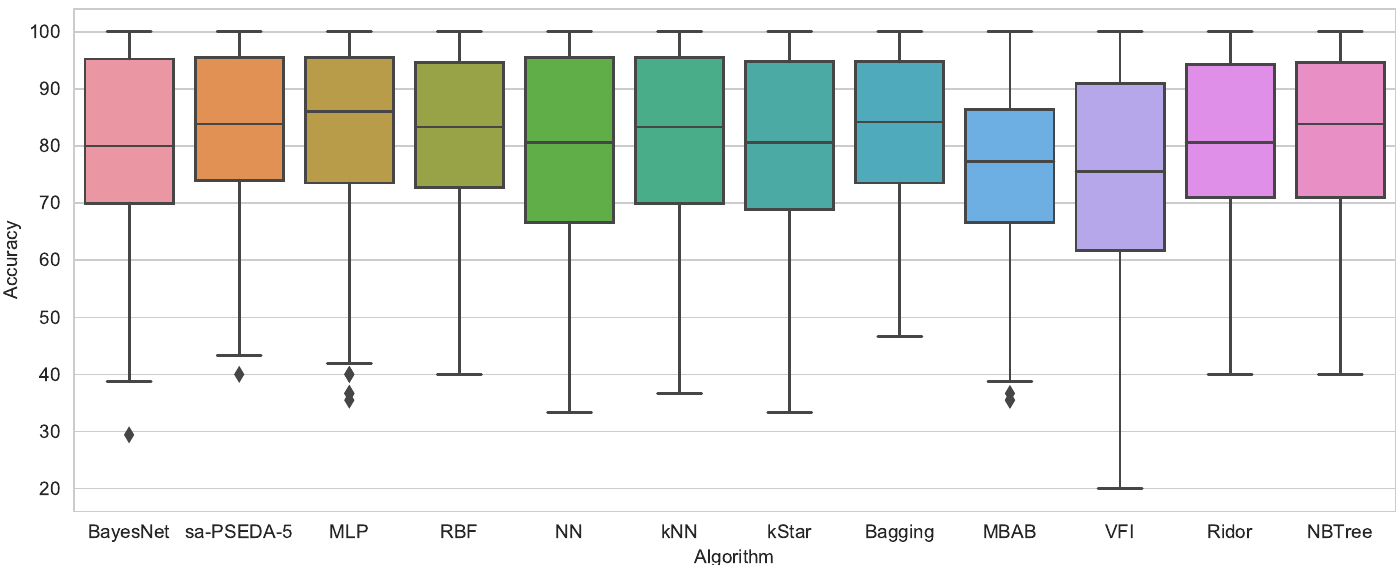
Figure 3. Box plots for sa-PSEDA- ψ 5 and the 11 state-of-the-art classification schemes from Reference